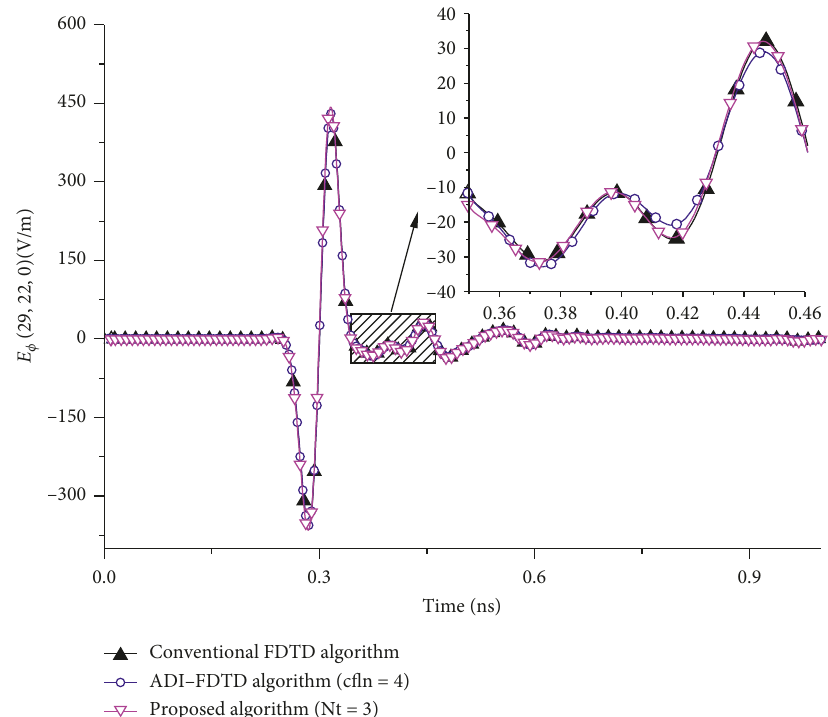
Figure 5: Computational results of E